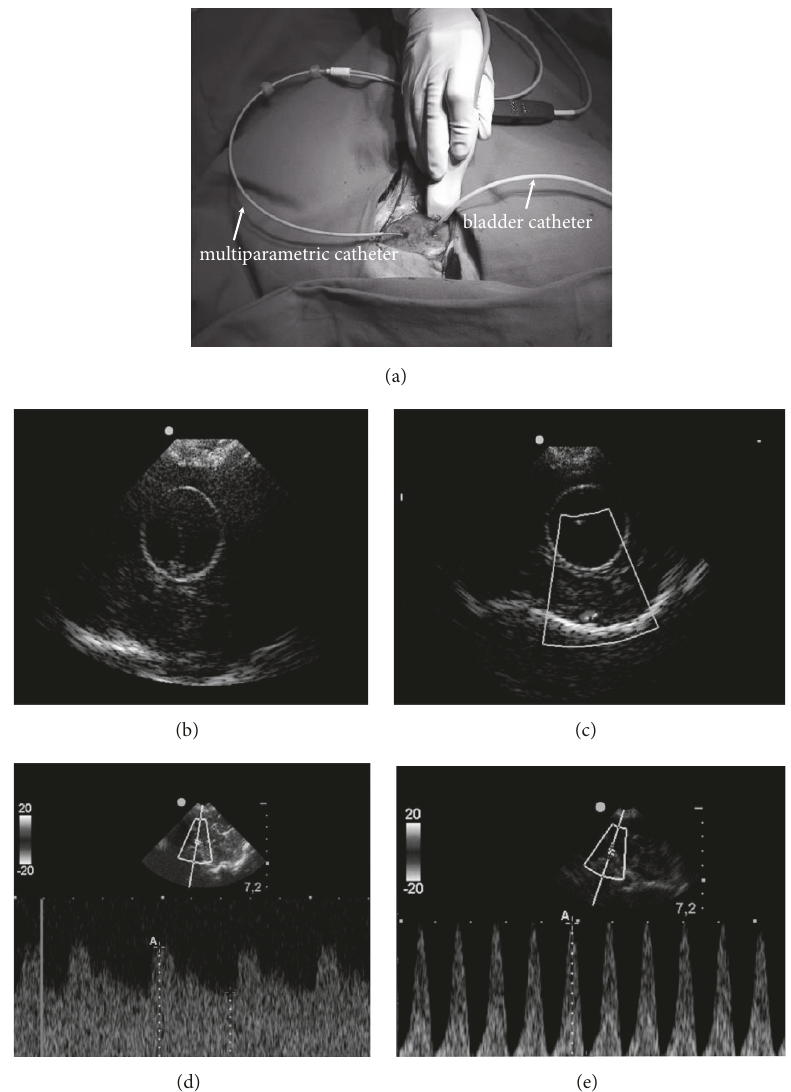
Figure 1: (a) Ultrasound transducer under the lateral hole, a multiparametric catheter in the anterior hole, and a bladder catheter in the posterior hole. (b and c) B-mode ultrasound duplex demonstrating the inflated balloon. Doppler mode was used to obtain CBFV before (d) and after balloon inflation